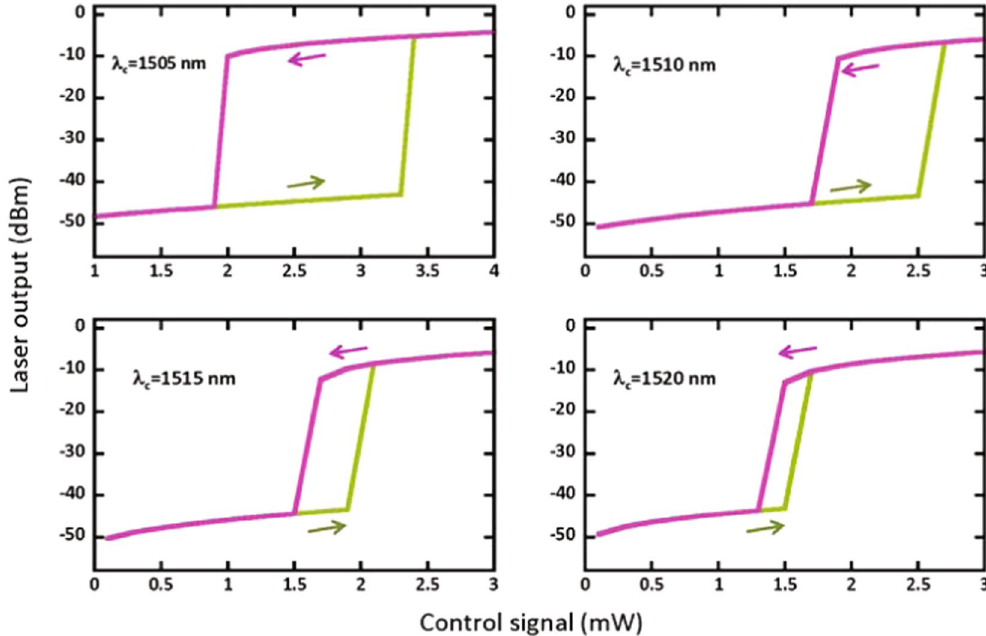
Figure 4. Laser output power versus the control signal for different wavelengths of control signal.